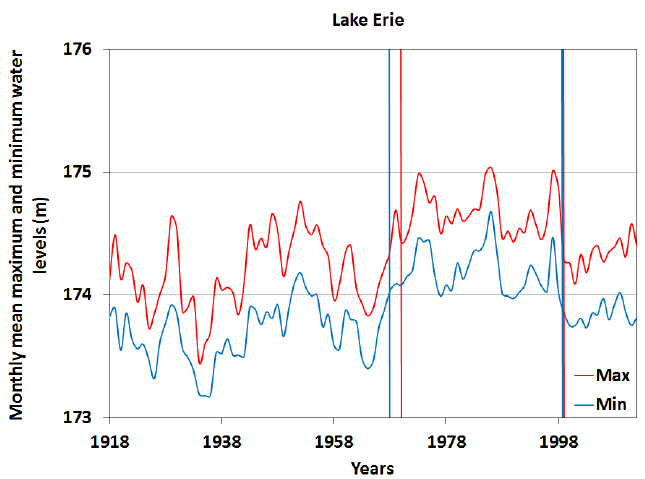
Figure 4. Temporal variability of monthly mean maximum ( red curve ) and minimum ( blue curve ) water levels in Lake Erie (1918–2012). The vertical lines represent the timing of the shift in mean values of the series.